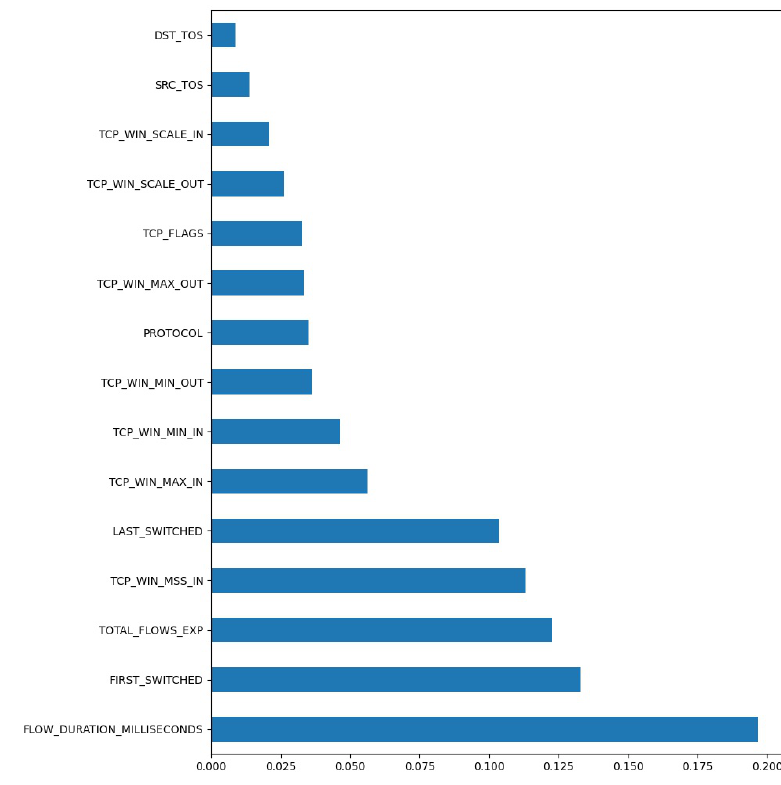
Figure 5. Result of feature